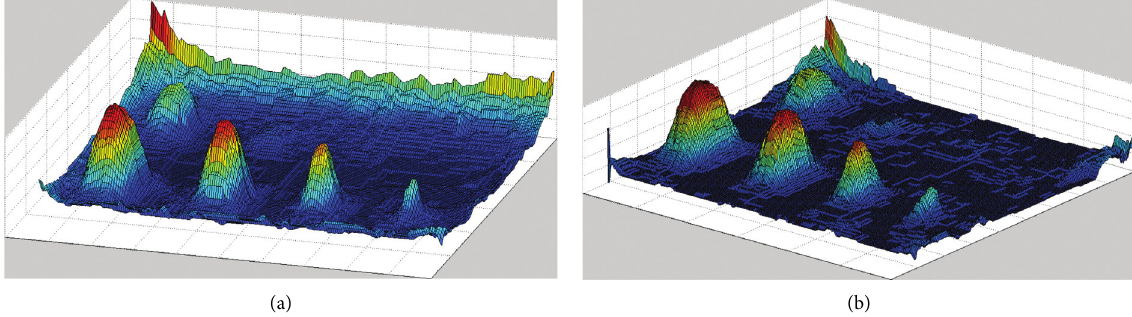
Figure 9: Preprocessing effect of specimen B. (a) Before preprocessing. (b) After preprocessing.